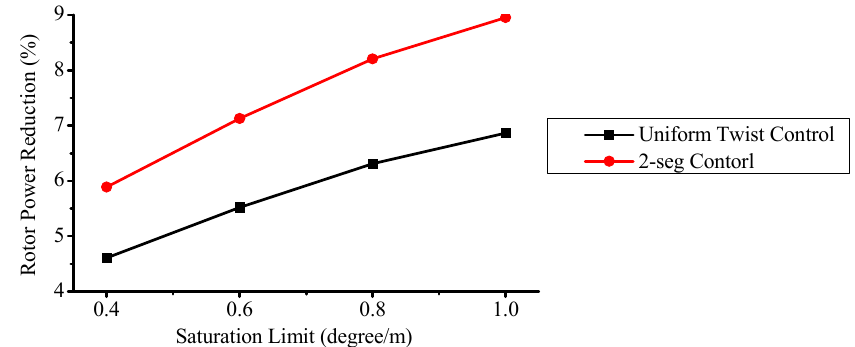
Figure 27. Rotor power reductions with saturation limits of active twist rate for condition B.